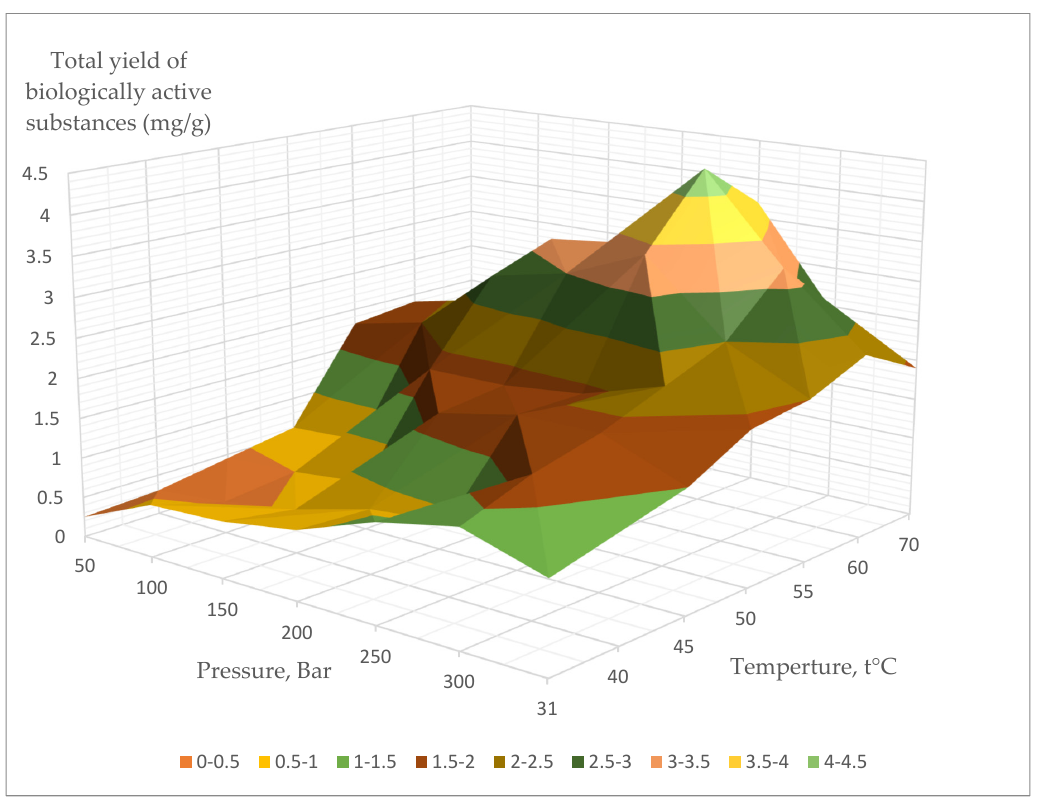
Figure 4. 3D–graph data of supercritical CO 2 -extraction. Total yield of biologically active substances from extracts of Z. marina (Seagrass collected in